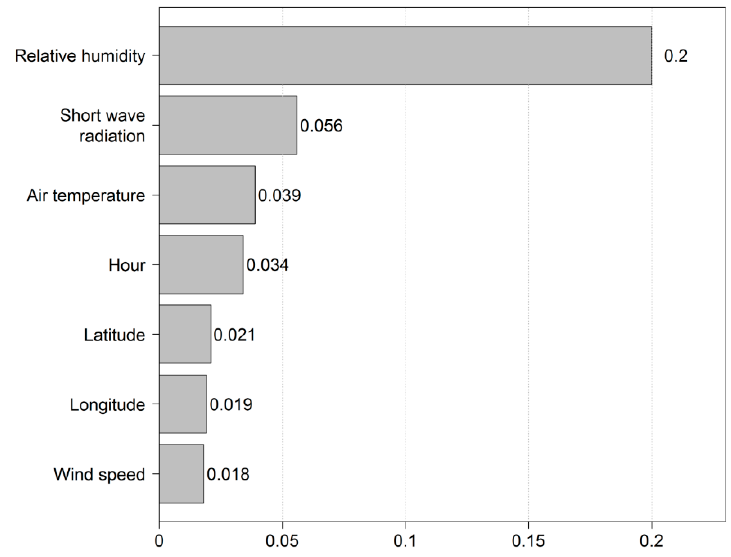
Figure 11. Plot of variable importance in the RF model.